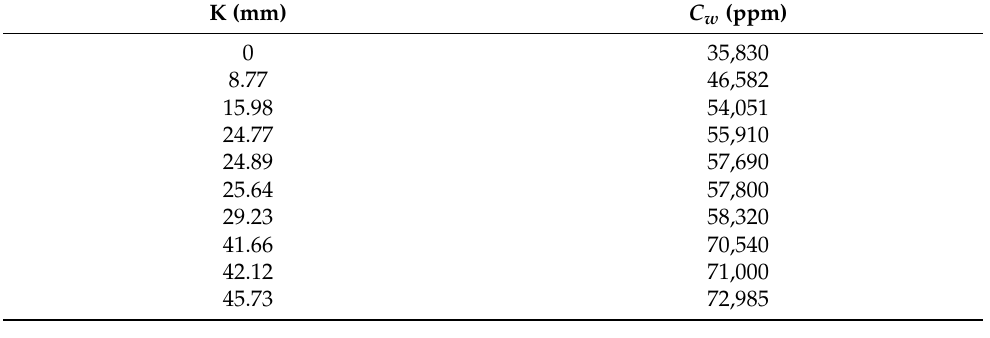
Table 2. The k value corresponding to the formation water salinity C w ( S w = 30%). K (mm)